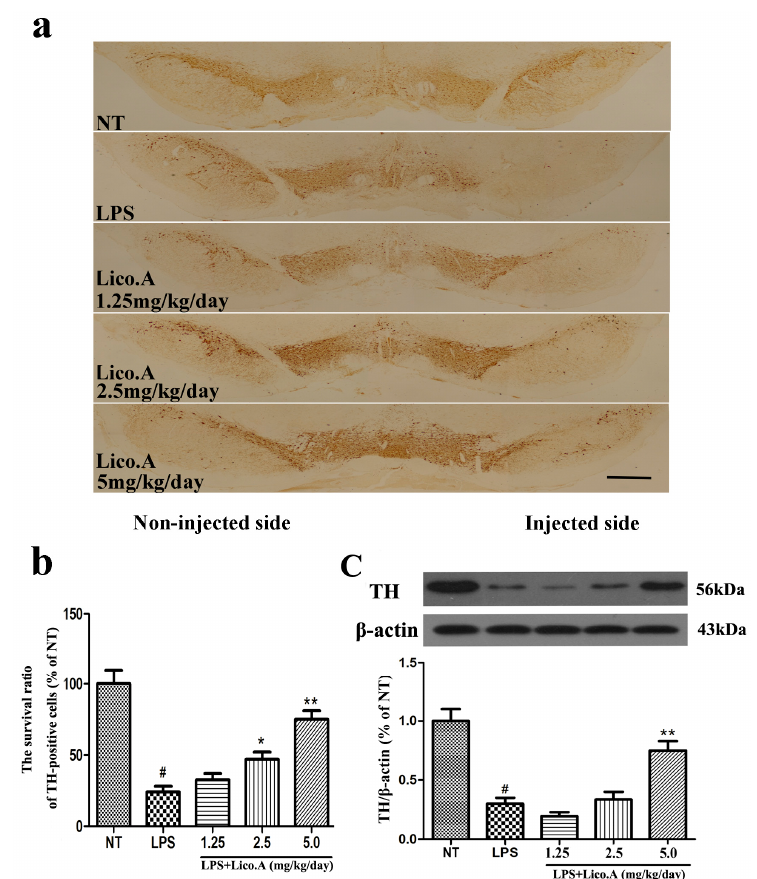
Figure 6. Lico.A treatment increases the number of TH-positive cells and TH expression in the SN of LPS-induced PD model rats. ( a ) Staining of TH-positive neurons in the SN was processed ( n = 6 per group). Scale bar, 1.0 mm; ( b ) The survival ratio of the dopaminergic neurons in the SNpc (TH-positive cells on the injected side versus the TH-positive cells on non-injected side) was calculated; ( c ) TH expression in the SN was assayed by Western blot ( n = 6 per group). A representative immunoblot is shown. The experiments were repeated three times. Values are mean ± SE. # p < 0.01, vs. NT group and * p < 0.05, ** p < 0.01 vs. LPS group.